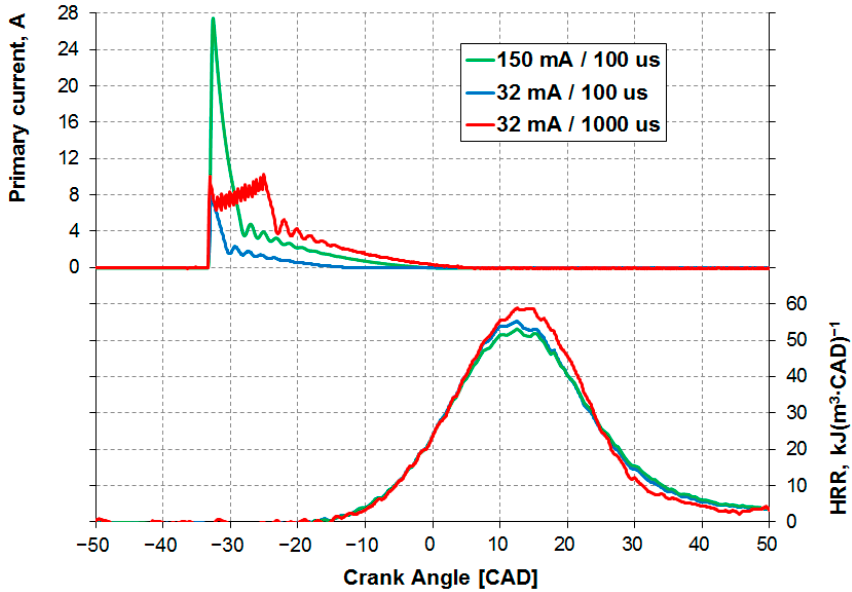
Figure 7. Heat release rate and primary coil current, for different ignition conditions, with MIX EQ2 at 1500 rpm and MAP 1250 mbar.